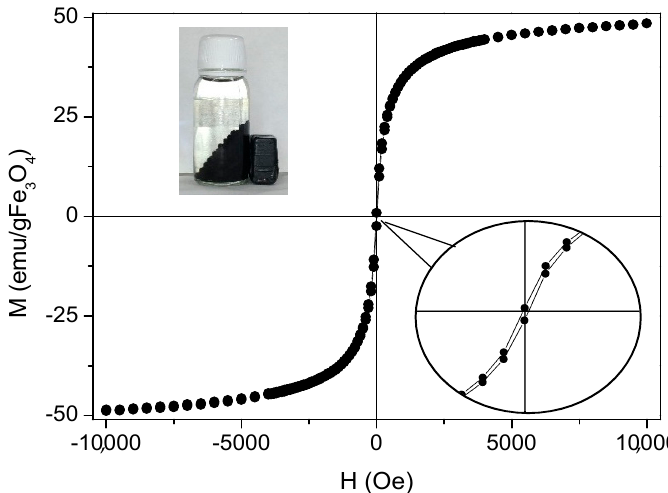
Figure 4. Magnetization curve of MAAC beads at 25 ° C. Insets: amplification of hysteresis cycle and digital photograph when an external magnet is applied to the MAAC beads.